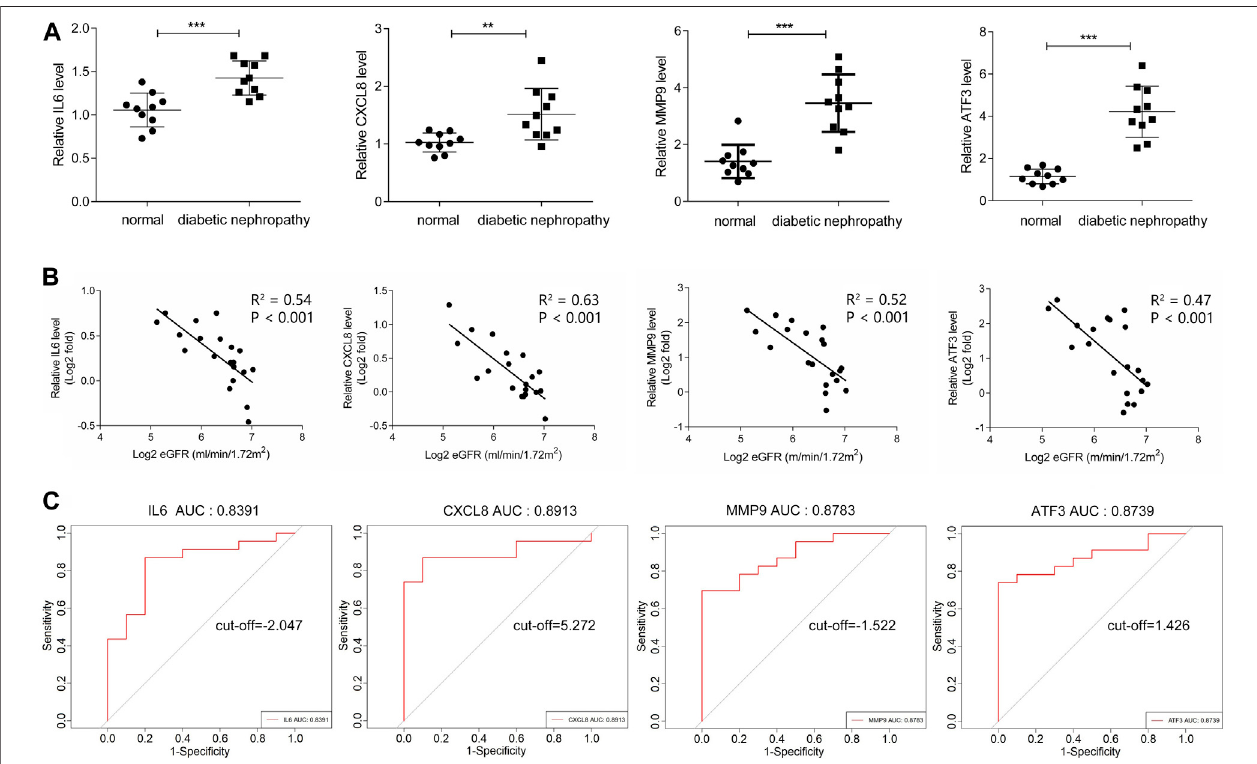
FIGURE 8 | Validation and Ef fi cacy Evaluation of HUB genes. (A) The expression of hub genes was detected by QPCR, compared with normal samples, all hub geneswereupregulated indiabetic nephropathysampleswithsigni fi cance. (B) Theexpression ofhubgeneswasnegativelycorrelatedwitheGFR. (C) ROCcurveofthe hub genes including IL6, CXCL8, MMP9 and ATF3 in